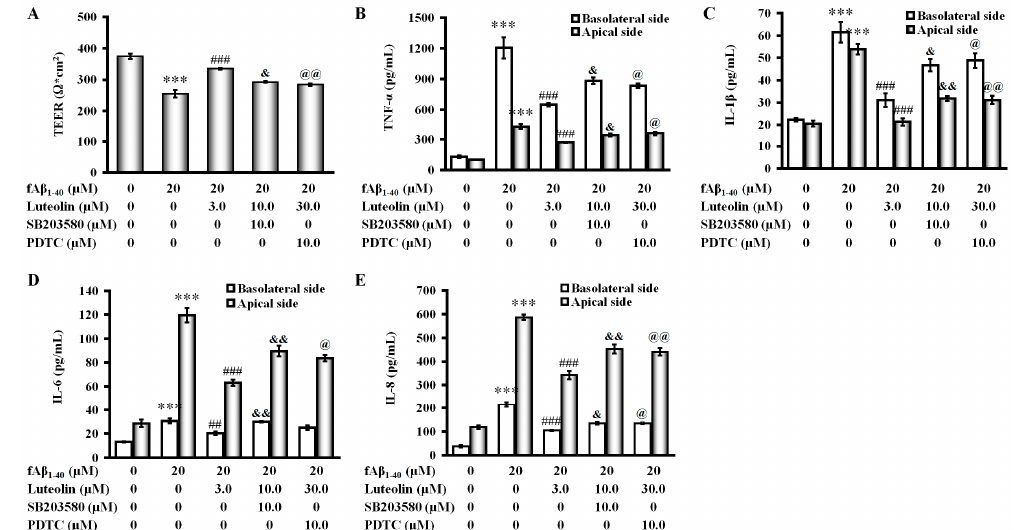
Figure 6. Effects of inhibition of p38 MAPK and NF- κ B on the effect of luteolin on fA β 1–40 -induced barrier dysfunction and inflammation. To block p38 MAPK and NF- κ B pathways, co-cultures were treated with p38 MAPK inhibitor SB203580 (4-(4-fluorophenyl)-2-(4-methylsulfinylphenyl)-5-(4- pyridyl)-1 H -imidazole, 10.0 µM) or NF- κ B inhibitor PDTC (pyrrolidine dithiocarbamate, 20.0 µM) for 30 min prior to treatment with luteolin. Abolished effects of p38 MAPK and NF- κ B inhibition of the effect of luteolin on TEER value ( A ); and production of TNF- α ( B ); IL-1 β ( C ); IL-6 ( D ); and IL-8 ( E ) were seen by treatment with SB203580 or PDTC. Data are expressed as the mean ± SEM; n = 4; *** p < 0.001 vs. control; ## p < 0.01; ### p < 0.001 vs. fA β 1–40 ; & p < 0.05; && p < 0.01 vs. luteolin combined with fA β 1–40 ; @ p < 0.05; @@ p < 0.01 vs. luteolin combined with fA β 1–40 .